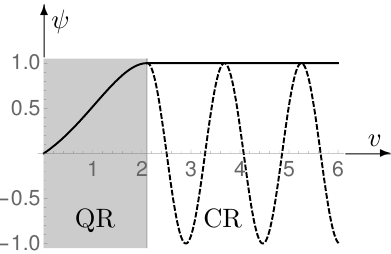
Figure 3. The full curve is a joint representation of the “soft entry” solution ψ ( v ) for the QR (gray filling) and ψ c ( v ) for the CR. The dashed curve shows ψ c ( v ) once again, but highly compressed in the horizontal direction in order to visualize the